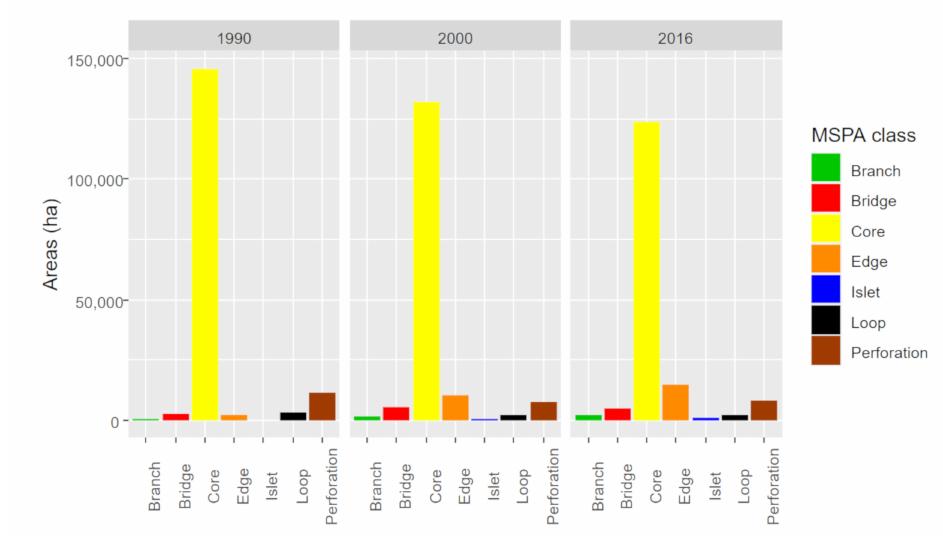
Figure 5. Comparison spatial patterns of green infrastructure for 1990, 2000 and 2016 in Gaoyou